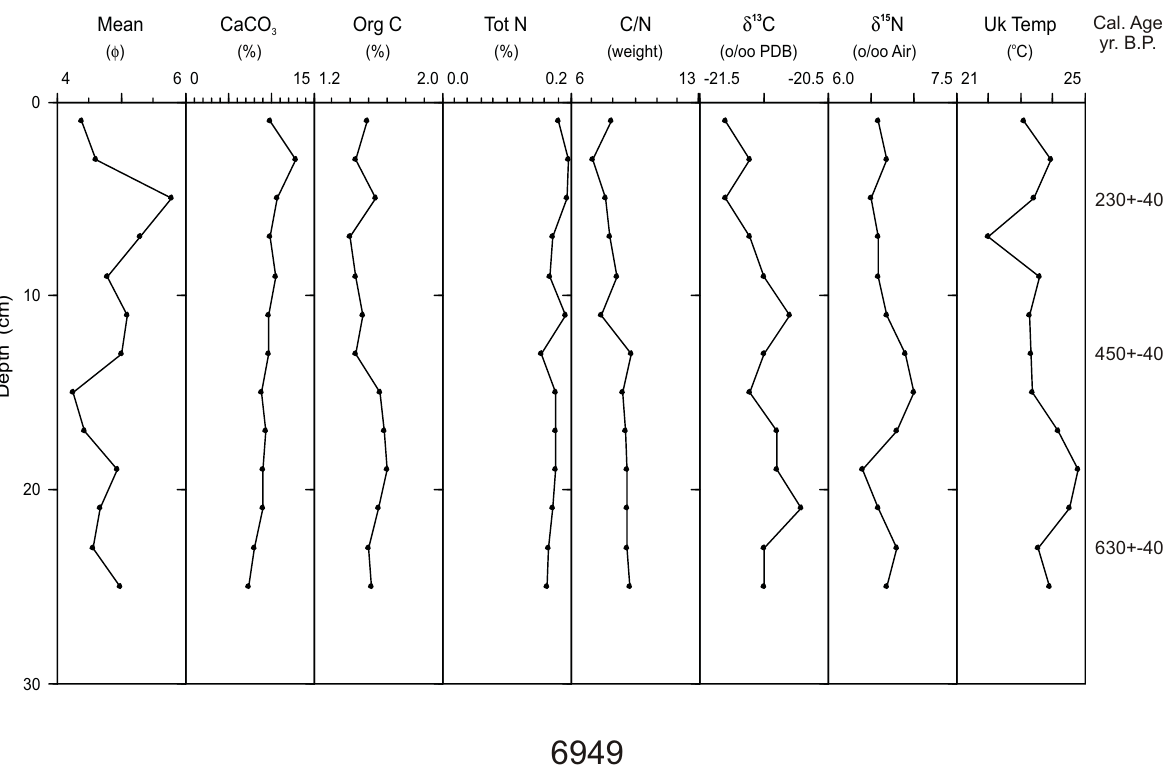
Fig. 3 – Mean grain-size, compositional, isotopic, and paleotemperature variations along core